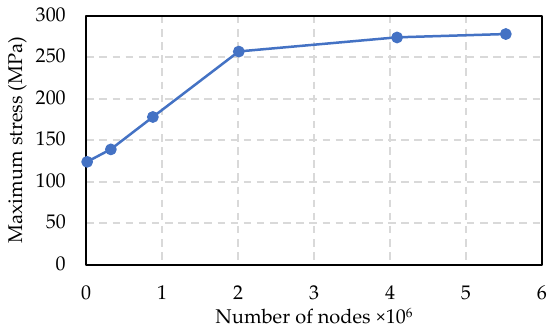
Figure 8. The calculation model of the support bracket.